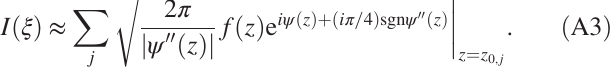
¼ 1 − ð 2 z=L − 1 Þ 2 u u